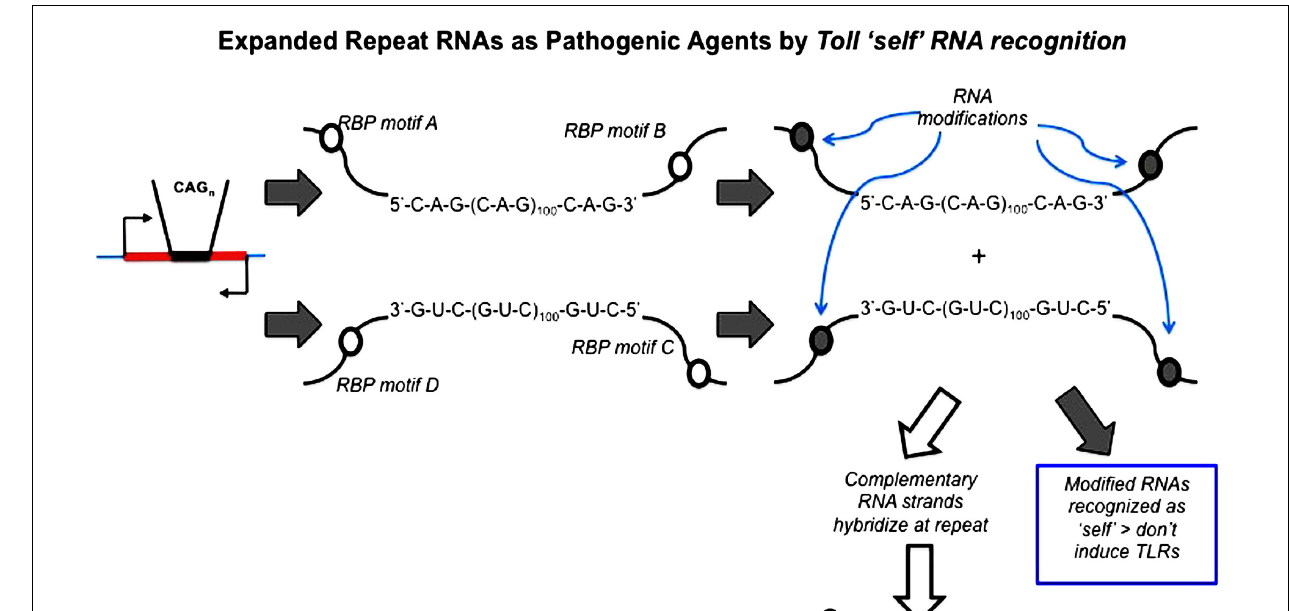
FIGURE 3 | Pathogenic mutations inAicardi–Goutières syndrome. Mutations in genes in at least six distinct loci are able give rise to the constellation of symptoms that defines Aicardi–Goutières syndrome. Four of these (AGS2, AGS3, AGS4, and AGS6) are in genes that encode RNA-metabolizing proteins.The remaining two that have been identified